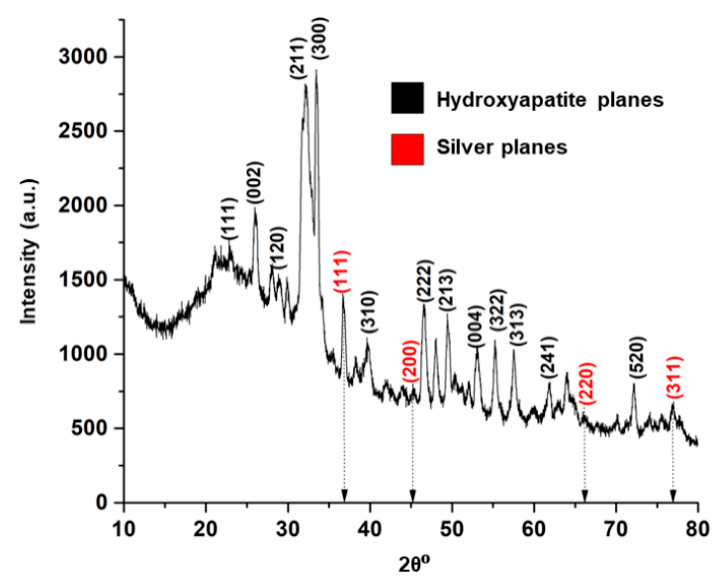
Figure 8. X-ray di ff raction pattern of the SiO 2 –HA composite doped with 10 mM AgNO 3 at 1 V for Figure 8. X-ray diffraction pattern of the SiO 2 –HA composite doped with 10 mM AgNO 3 at 1 V for 5 5 min.